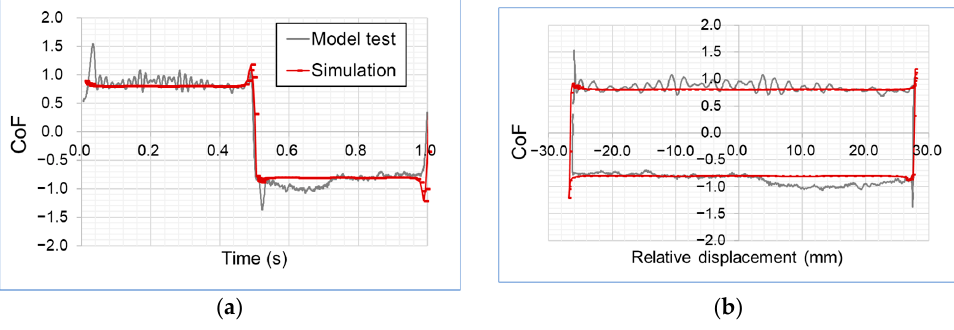
Figure 16. Coefficient of friction over ( a ) time and ( b ) relative displacement.